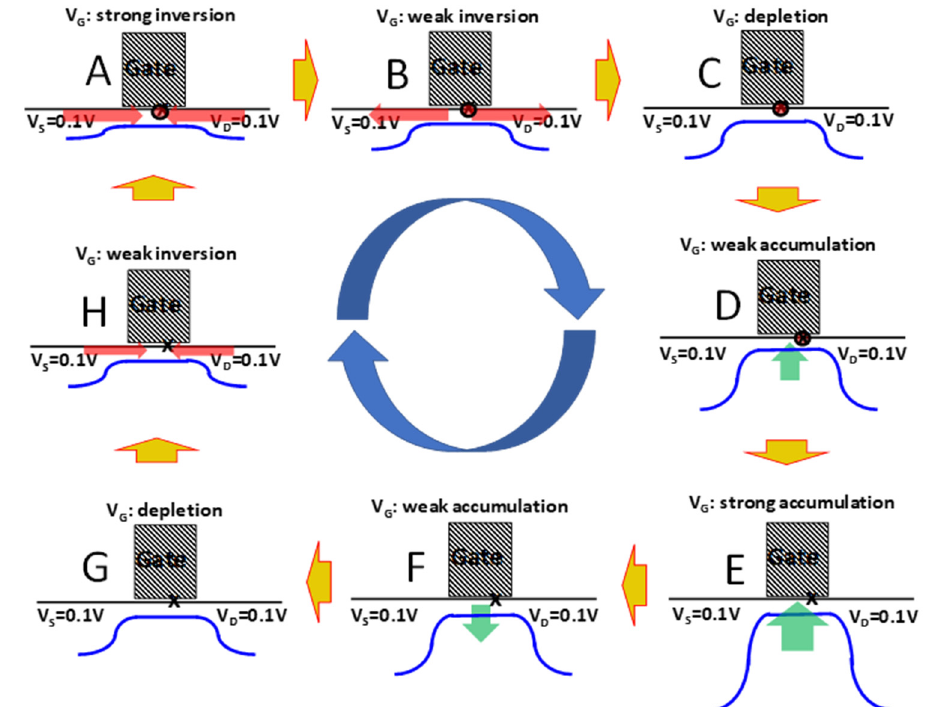
Figure 3. Illustration of the charge-pumping concept. Blue line is the surface potential drawing in one dimension varying from source to drain. Red arrows indicate electron flux (minority carriers in a n-channel metal-oxide-semiconductor field-e ff ect-transistor (MOSFET)). Green arrows indicate hole flux. X indicates an interface defect, and x with a red circle indicates an electron is captured on the defect site. The cycling of the gate voltage from strong inversion ( A ) to depletion ( D ) to strong accumulation ( E ) to depletion ( G ) and back to ( A ) serves to modulate the surface potential in the channel and therefore controls the flow of electrons from source and drain and holes from the substrate.